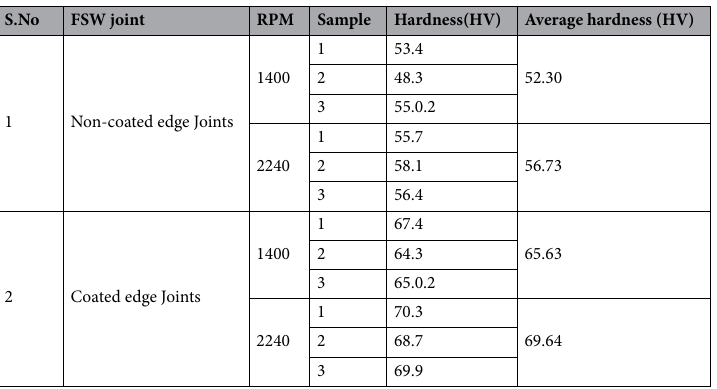
Table 4. Hardness of